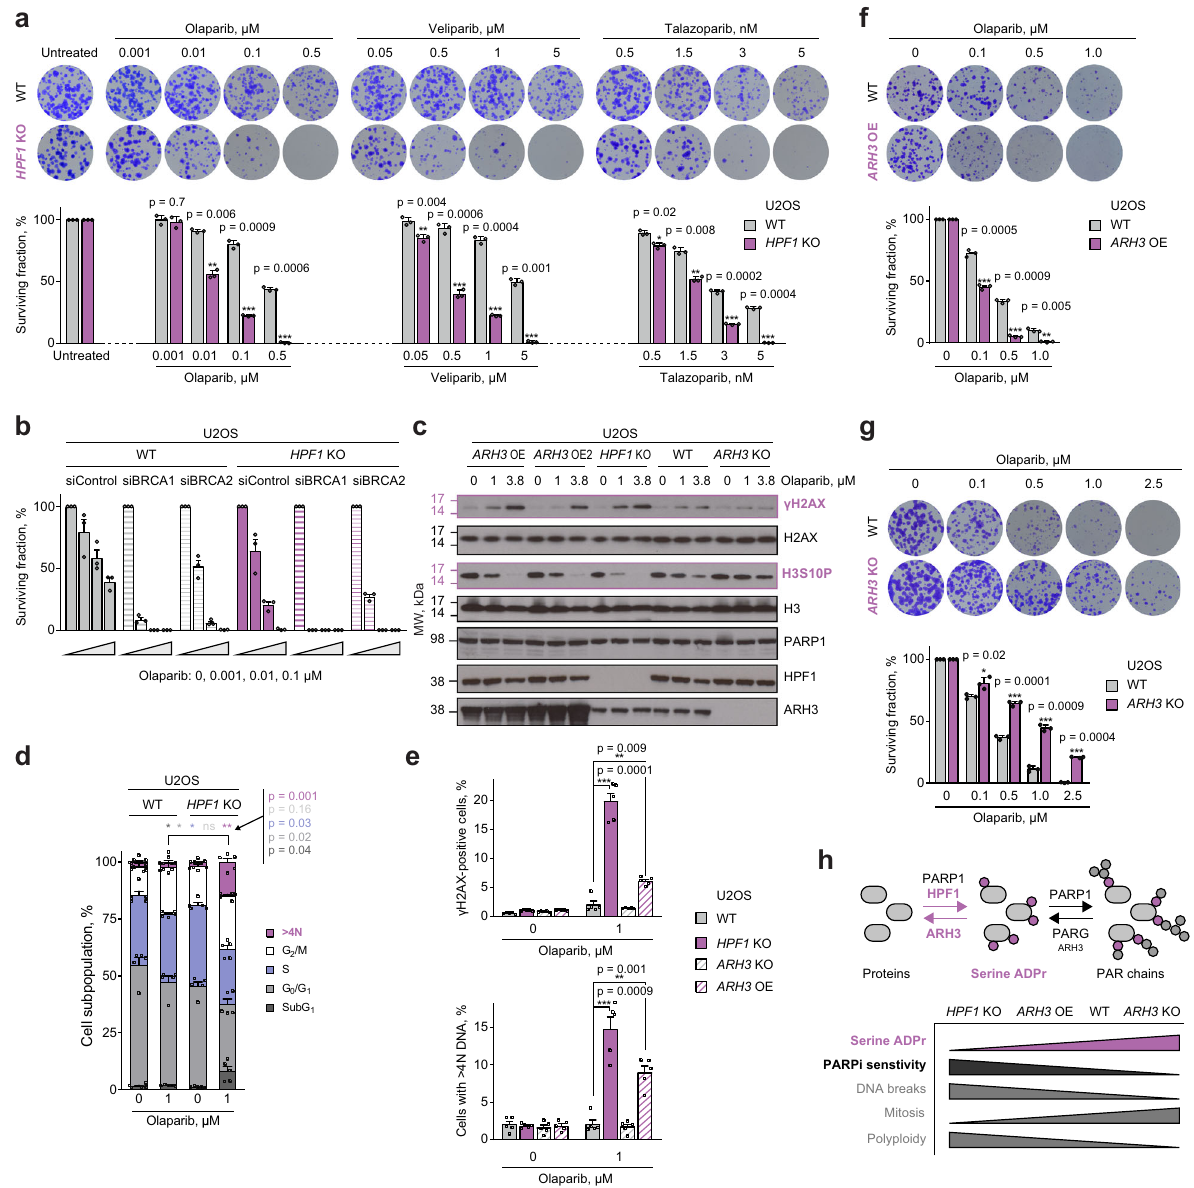
Fig. 1 PARP1/PARP2 inhibitor sensitivity is determined by serine ADPr levels, which are controlled by HPF1 and ARH3 activity. a Reduced survival of HPF1 KO cells after treatment with the indicated PARP1/PARP2 inhibitors. Representative images (top) and quanti fi cation of colony formation assay (bottom). b HPF1 loss results in further sensitisation of BRCA1- or BRCA2-de fi cient cells to Olaparib. See Supplementary Fig. 2a for BRCA1, BRCA2, HPF1 and tubulin control immunoblots. c Effects of 6-day Olaparib treatment on γ H2AX formation and H3S10P reduction depend on cellular HPF1 and ARH3 protein levels. The experiment was repeated independently 3 times with similar results. See Supplementary Fig. 2b for Pan ADPr immunoblot. A repeat of the experiment with an additional concentration of Olaparib is provided in Supplementary Fig. 2c. d Flow cytometry analysis of cell cycle pro fi les following 4-day exposure to Olaparib. Asterisks in different colours indicate signi fi cant difference in corresponding cell populations between WT and HPF1 KO cells. e HPF1 and ARH3 status determines the effects of 4-day Olaparib treatment on γ H2AX levels (top) and percentage of cells with >4 N DNA (bottom) as determined by fl ow cytometry. f ARH3 overexpression (OE) renders cells more sensitive to PARP1/PARP2 inhibition. g Loss of ARH3 confers resistance to Olaparib. h Schematic representation of ADPr synthesis and removal (top), and summary of the impact of HPF1 and ARH3 status on cell serine ADPr levels and PARP1/PARP2 inhibitor (PARPi) sensitivity (bottom). a , f , g Data are shown as mean ± SD of three independent experiments. b , d , e Data are shown as mean ± SEM of three ( b ) or fi ve ( d , e ) independent experiments. * p < 0.05; ** p < 0.01; *** p < 0.001 (two-tailed Student ’ s t -test). Flow cytometry